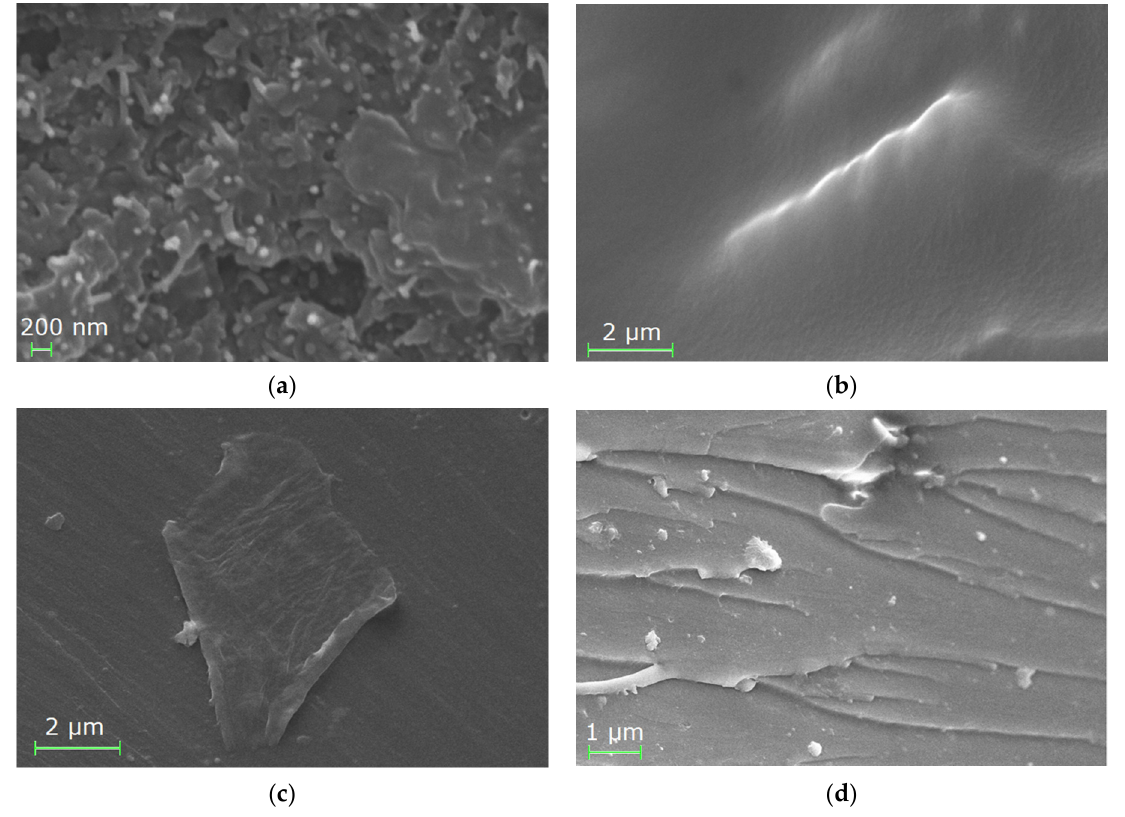
Figure 2. SEM images of the nanocomposites with 3 phr: ( a ) CB; ( b ) MWCNT; ( c ) GnP; ( d ) ND content. Table 6. Glass transition temperature as determined via DSC test, for all examined